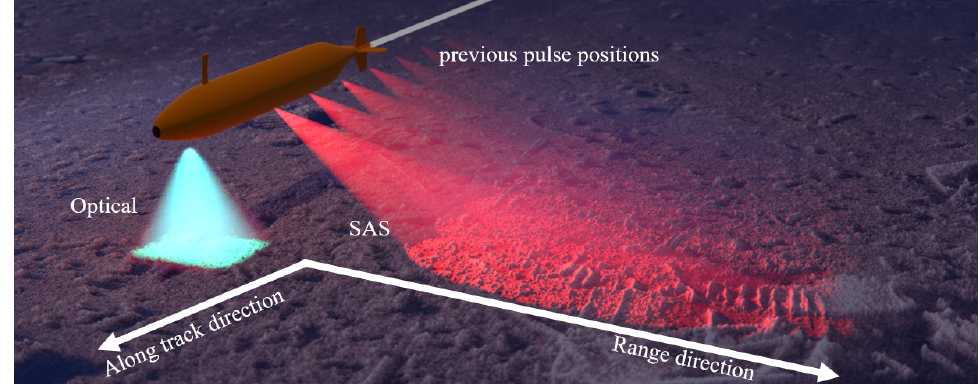
Figure 2. The geometry of data collection from an autonomous underwater vehicle (AUV). Synthetic aperture sonar (SAS) images the seafloor at a low grazing angle. Optical images are taken from a top-down orientation illuminated by a colocated light on the AUV. A typical AUV fly height for camera runs is six meters and 25–30 m for SAS runs in deep